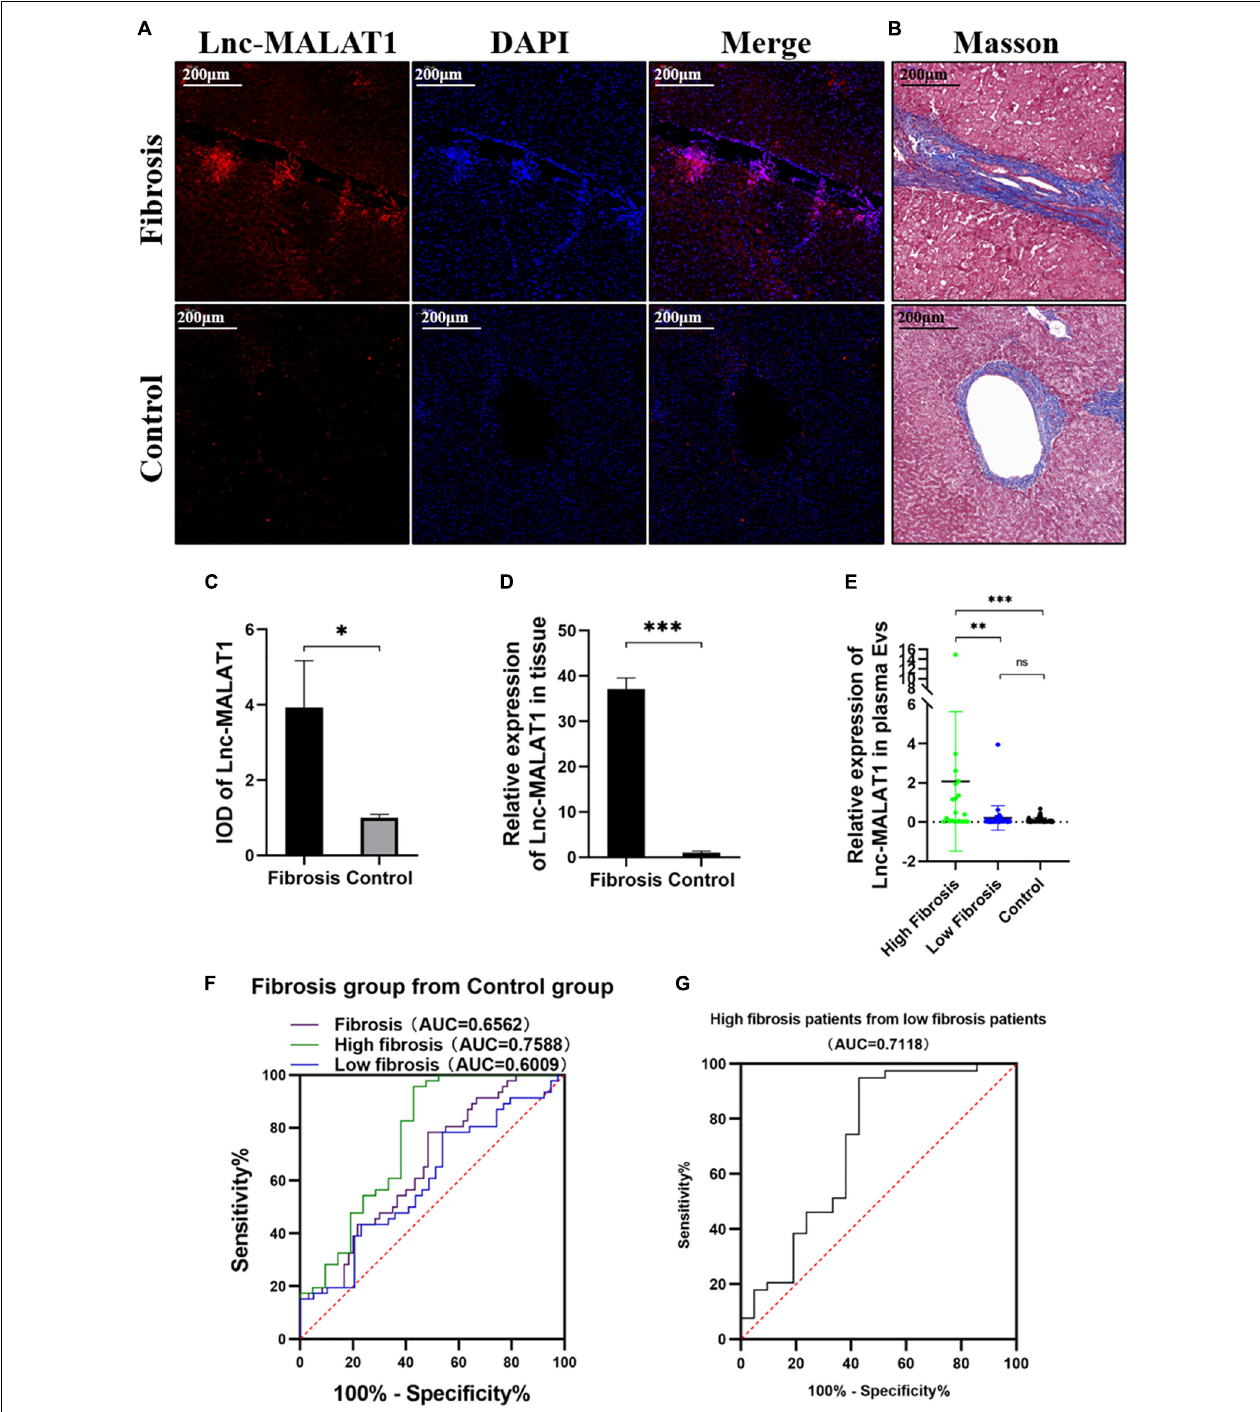
FIGURE 1 | Expression of Lnc-MALAT1 in the fibrotic liver tissues and plasma EVs-Lnc-MALAT1 as a potential diagnostic marker. (A) Representative image of fluorescence in situ hybridization (FISH) targeting Lnc-MALAT1 in the liver specimens from the high fibrosis group and the control group; (B) Representative image of Masson staining in the consecutive tissue slides. (C) Relative integral optical density (IOD) value of Lnc-MALAT1 measured by Image-pro plus ( n = 6 in each group. (D) Levels of Lnc-MALAT1 in the liver tissues determined by qRT-PCR ( n = 6 in each group). (E) Scatter plot of the Lnc-MALAT1 expression in plasma EVs derived from the high fibrosis group ( n = 21), low fibrosis group ( n = 39) and control group ( n = 46). (F) ROC analysis of the EVs-Lnc-MALAT1 level as a diagnostic marker for liver fibrosis. (G) ROC analysis of the EVs-Lnc-MALAT1 level for discrimination of high fibrosis from low fibrosis. ∗ , ∗∗ , and ∗∗∗ represent p- values less than 0.05, 0.01, and 0.001,